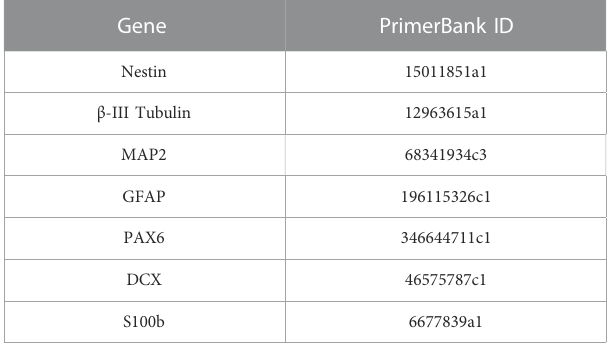
TABLE 2 Genes used in the qRT-PCR